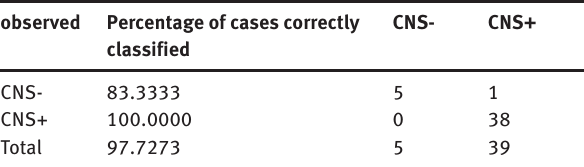
Table 4: Classification matrix for model with discriminating variables ( B2, eL and R /PSA) (12, f